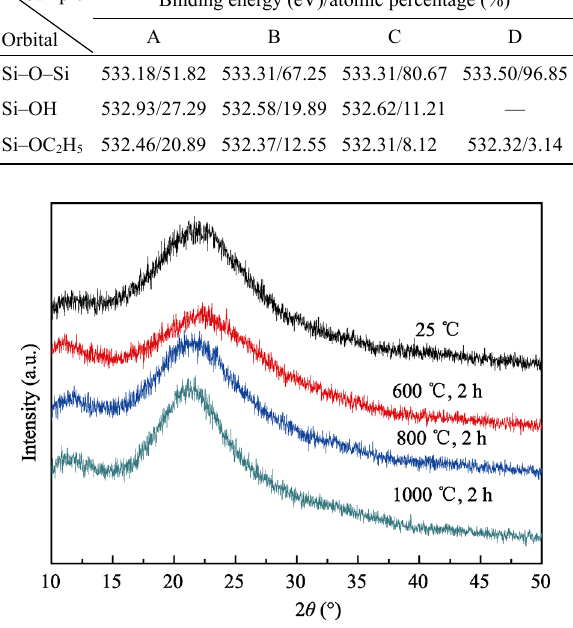
Fig. 3 O 1s XPS spectra of aerogels treated at different temperatures: (A) as-synthesized; (B) 400 ℃ , 2 h; (C) 600 ℃ , 2 h; (D) 800 ℃ , 2 h. Quantitative O 1s XPS analysis of SiO 2 aerogels calcined at different temperatures Binding energy (eV)/atomic percentage (%) Sample